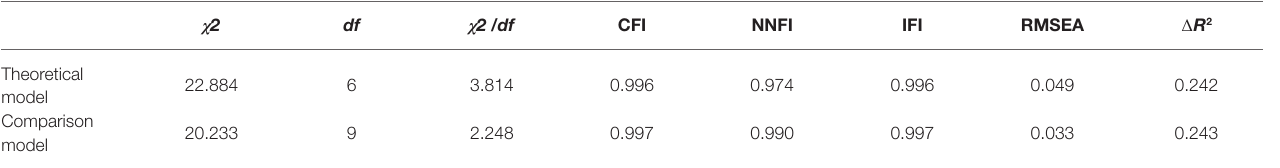
TABLE 3 | Comparison of partial and full mediation models.